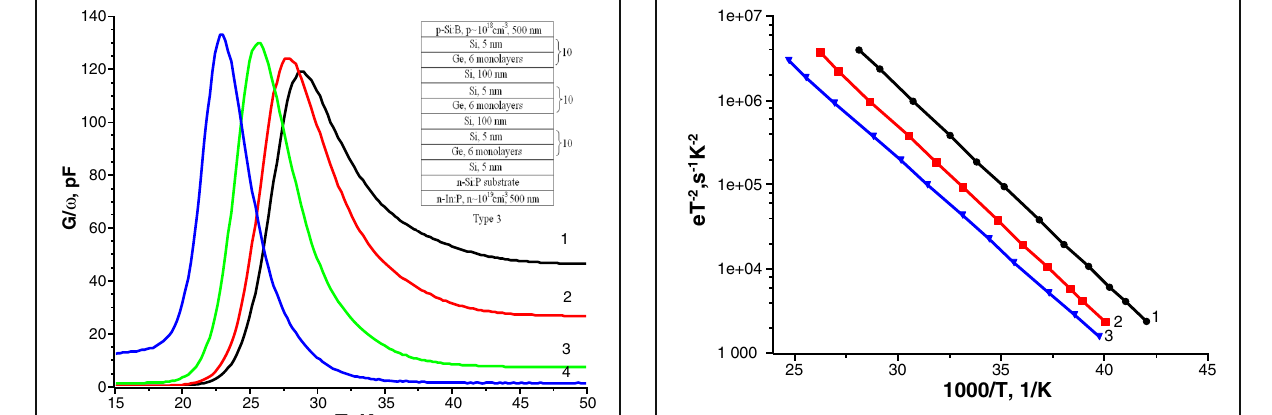
Fig. 4 Arrhenius plots built for the positions of the maxima of the temperature spectra of conductance of type 1 samples at various bias voltages 1 − 1 V, 2 − 0.5 V, and 3 − 0 V